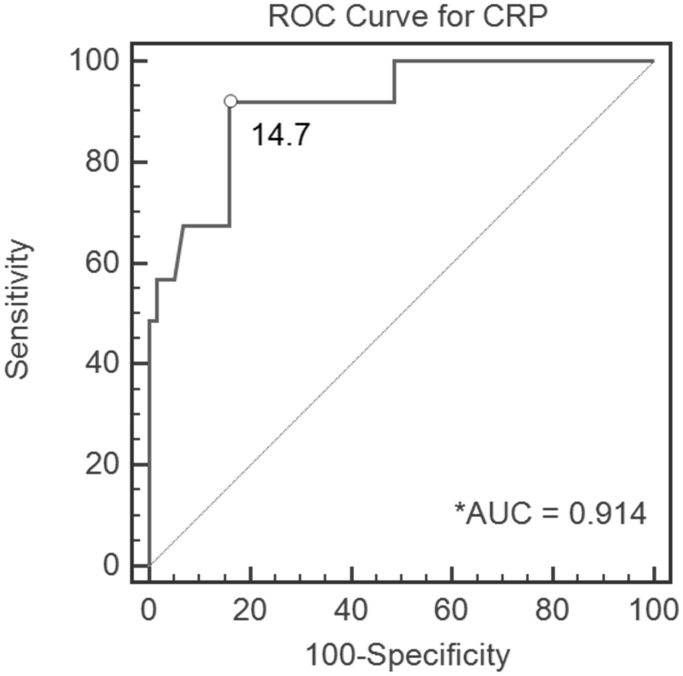
Receiver operating characteristic (ROC) curve, demonstrating the C-reactive protein (CRP) level cutoff value of 14.6 mg/L for all patients in the cohort.*AUC, area under the curve.